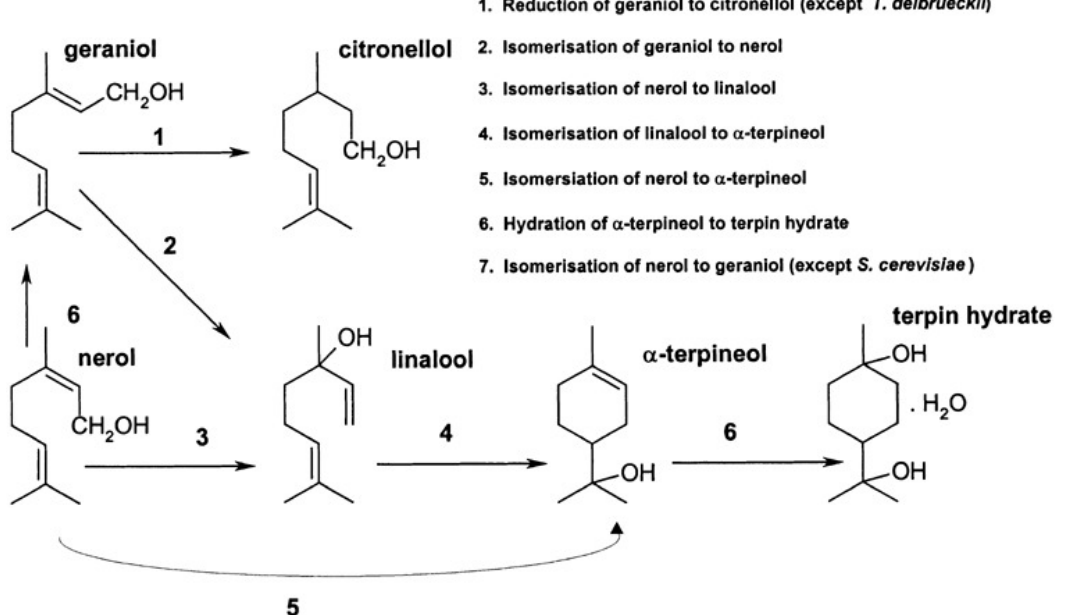
Figure 6. Scheme showing the monoterpenoid biotransformation reactions catalysed by S. cerevisiae , Torulspora delbrueckii , and Kluyveromyces lactis ; adapted from [78]. Torulspora delbrueckii , and Kluyveromyces lactis ; adapted from